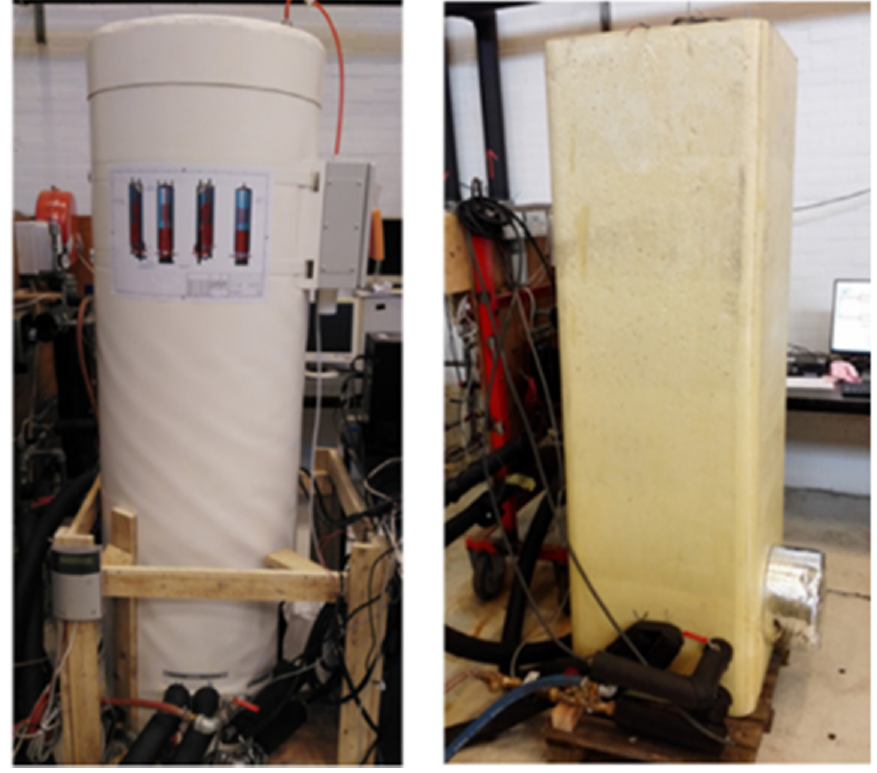
Figure 17. An experimental setup of a prototype ( left ) and improved ( right ) solar water tank. Adapted with permission from ref. [137] 2018 Deng et al.